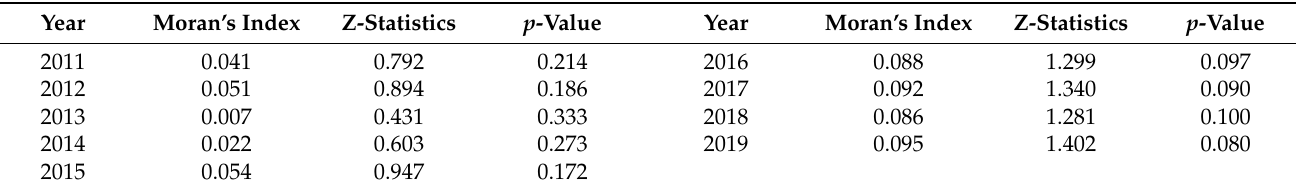
Table 6. Global Moran’s I of agricultural carbon intensity in China from 2011 to